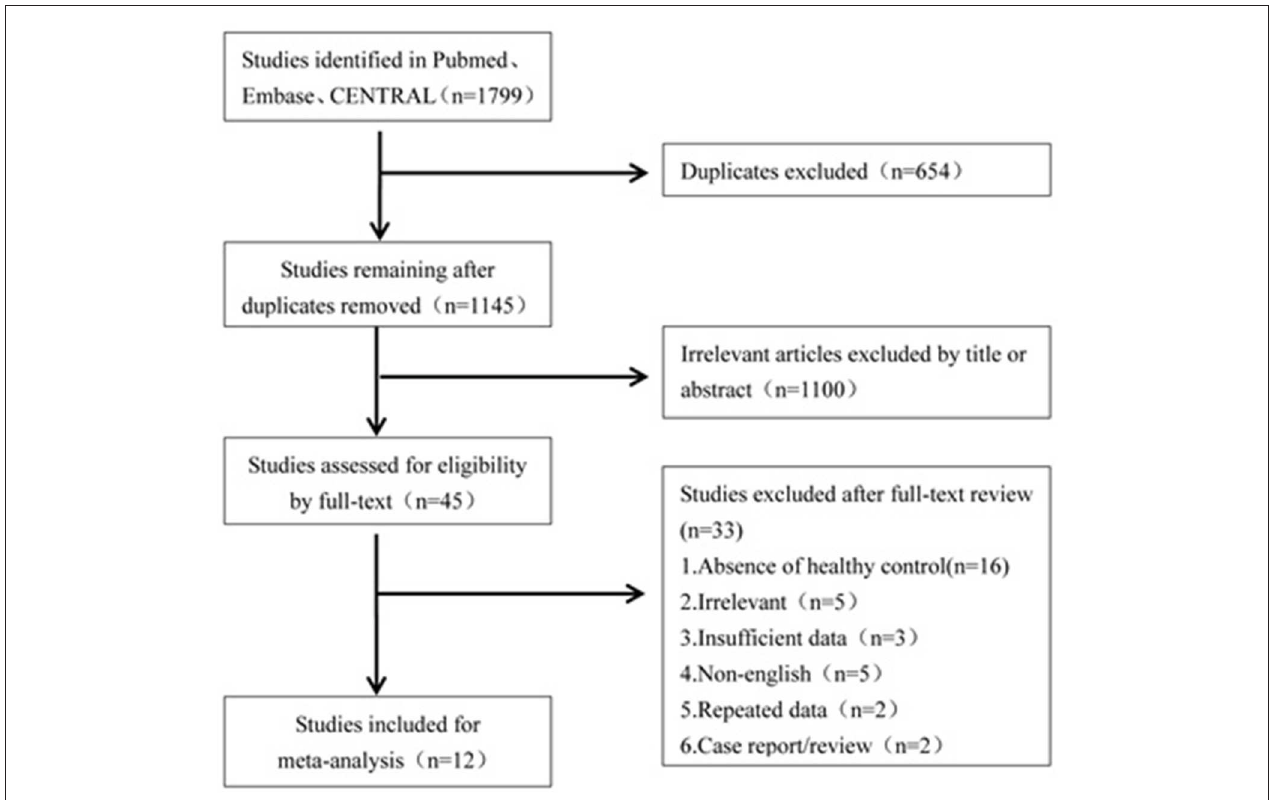
FIGURE 1 | Flowchart of data search and studies selection for